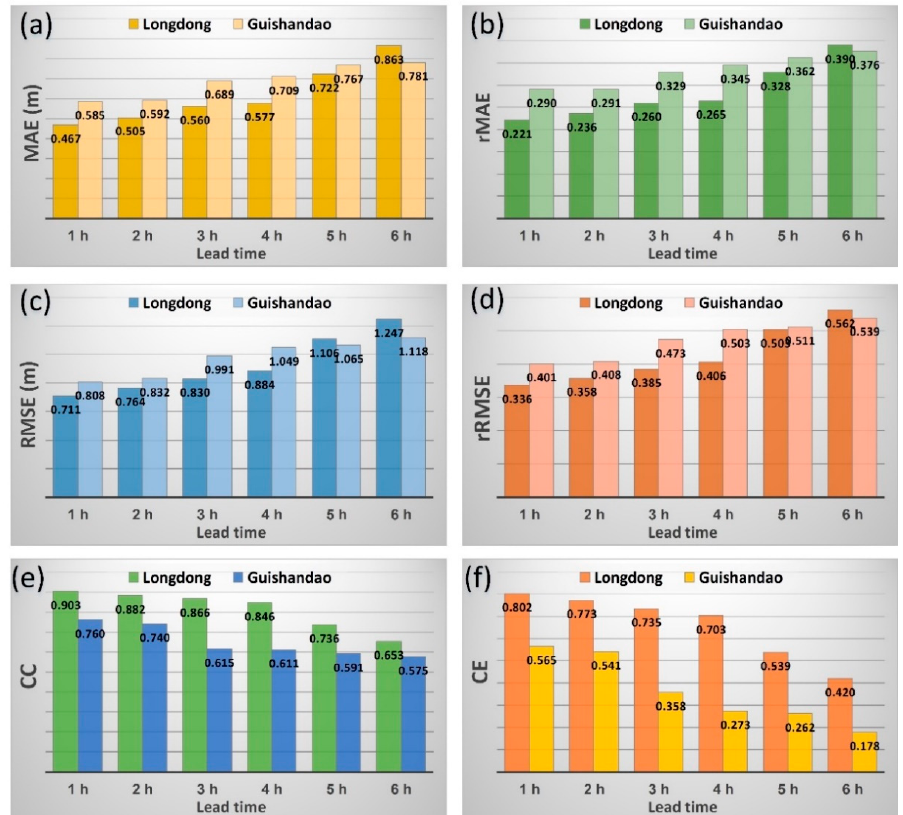
Figure 14. Evaluation indexes for wave height prediction of lead time = 1 to 6 h at Longdong and Guishandao buoys: ( a ) MAE; ( b ) rMAE; ( c ) RMSE; ( d ) rRMSE; ( e ) CC; and ( f ) CE.